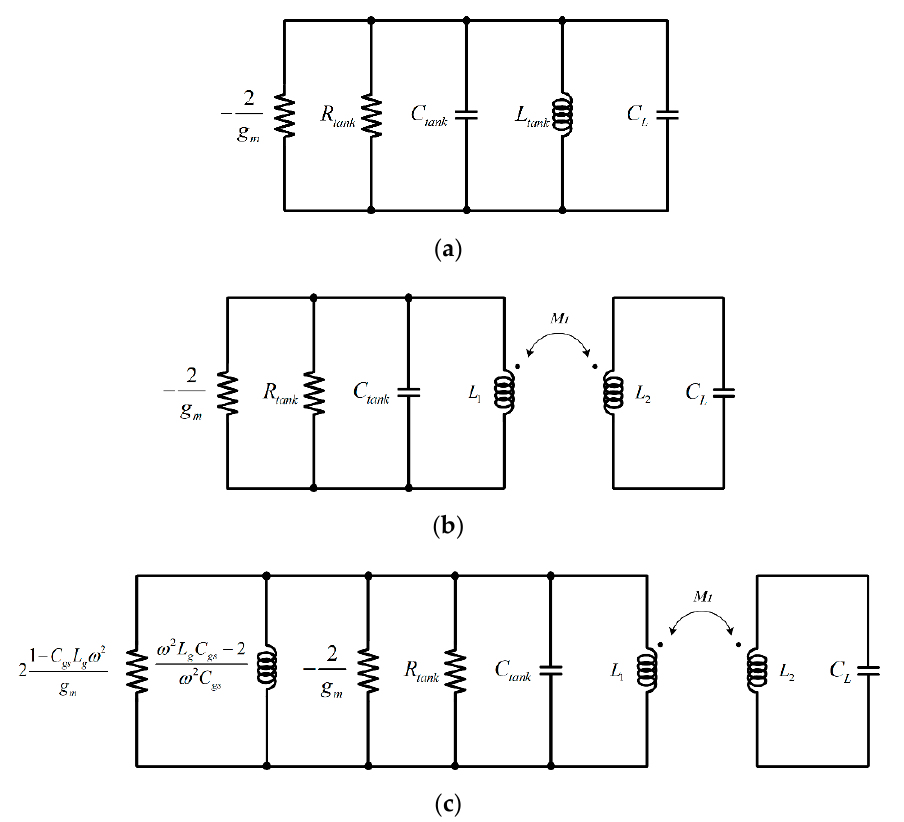
Figure 3. Small signal equivalent circuits of: ( a ) conventional XCO; ( b ) XCO with CLRC; ( c ) proposed oscillator.